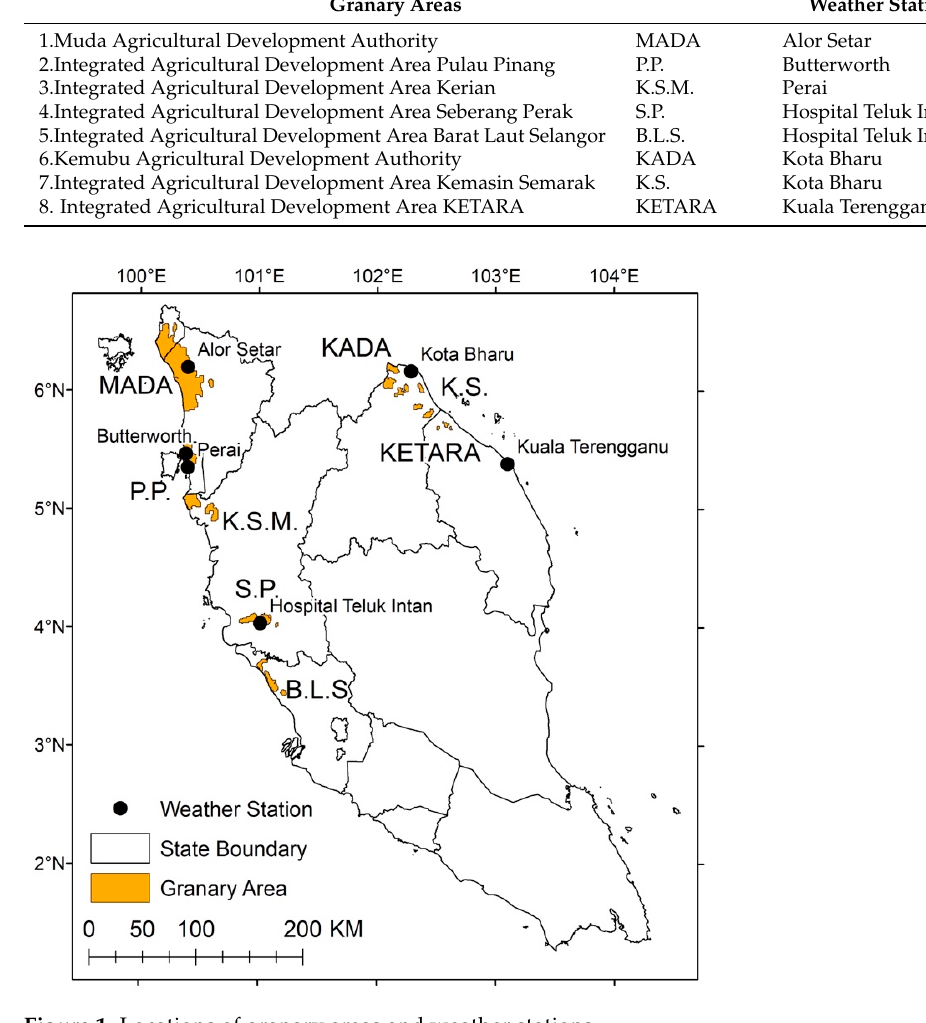
Figure 1. Locations of granary areas and weather stations. Table 2. Variable description.